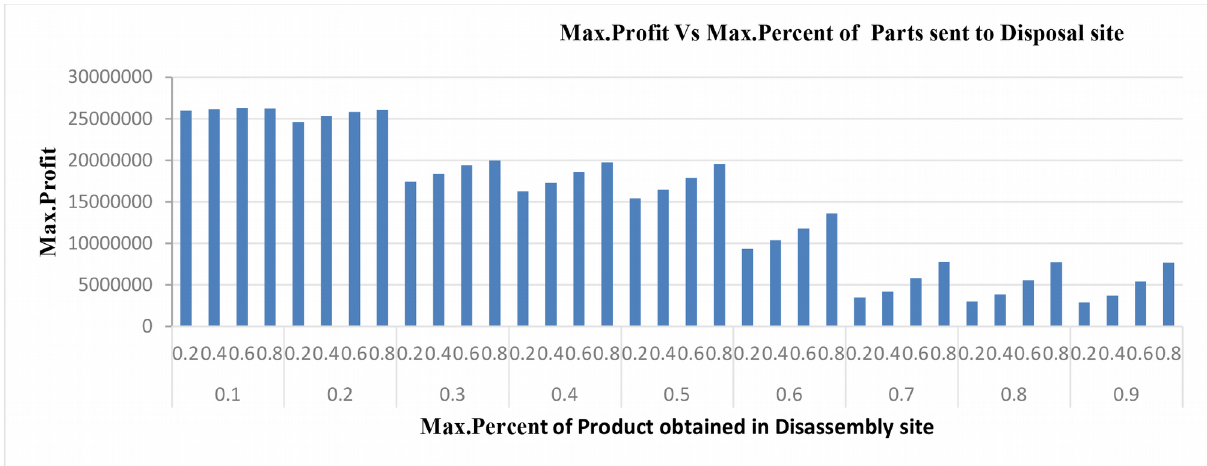
Figure 5. Profit Vs Percent of Parts sent to Disposal